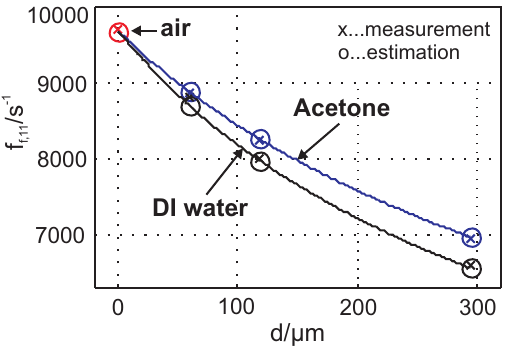
Figure 9. Shows the resonance frequency of the (1 / 1) mode ver- sus the gap-width d between the membranes for the vibration in air, acetone and water. Measurements are indicated with an (x) and estimations using Eq. (10) are marked by the lines and the